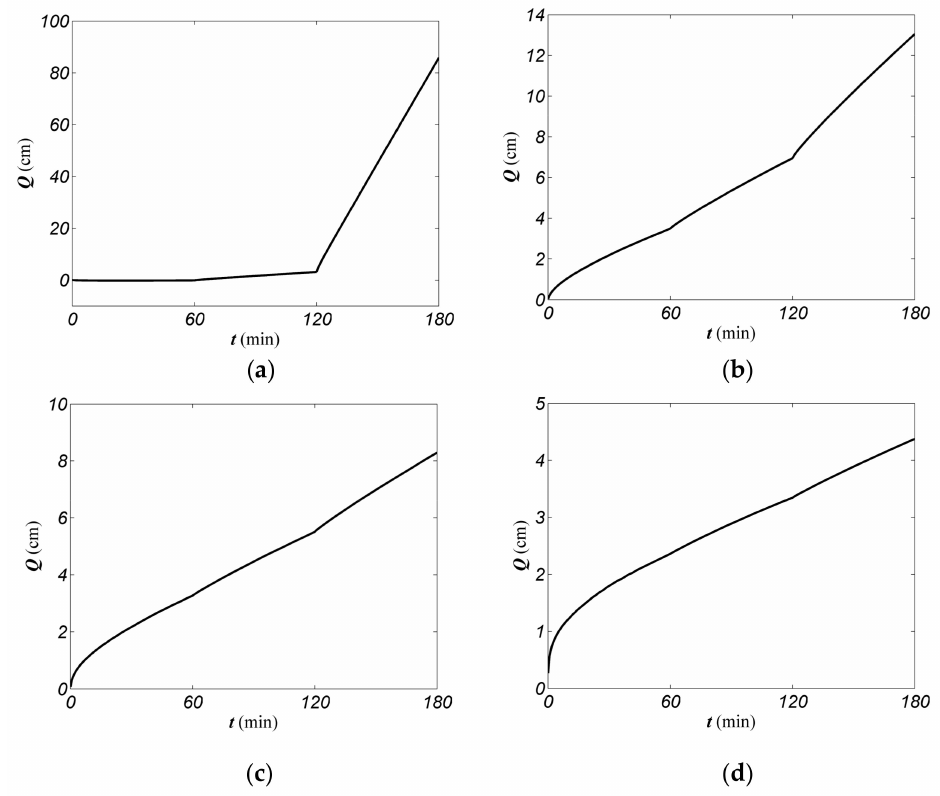
Figure 3. Cumulative infiltration versus time for four types of soil with three consecutive supply matric potentials ( h 0 ( t = 0) = − 15 cm; h 0 ( t = 60) = − 10 cm; and h 0 ( t = 120) = − 3 cm): ( a ) Sand; ( b ) Loam; ( c ) Silt; and ( d )